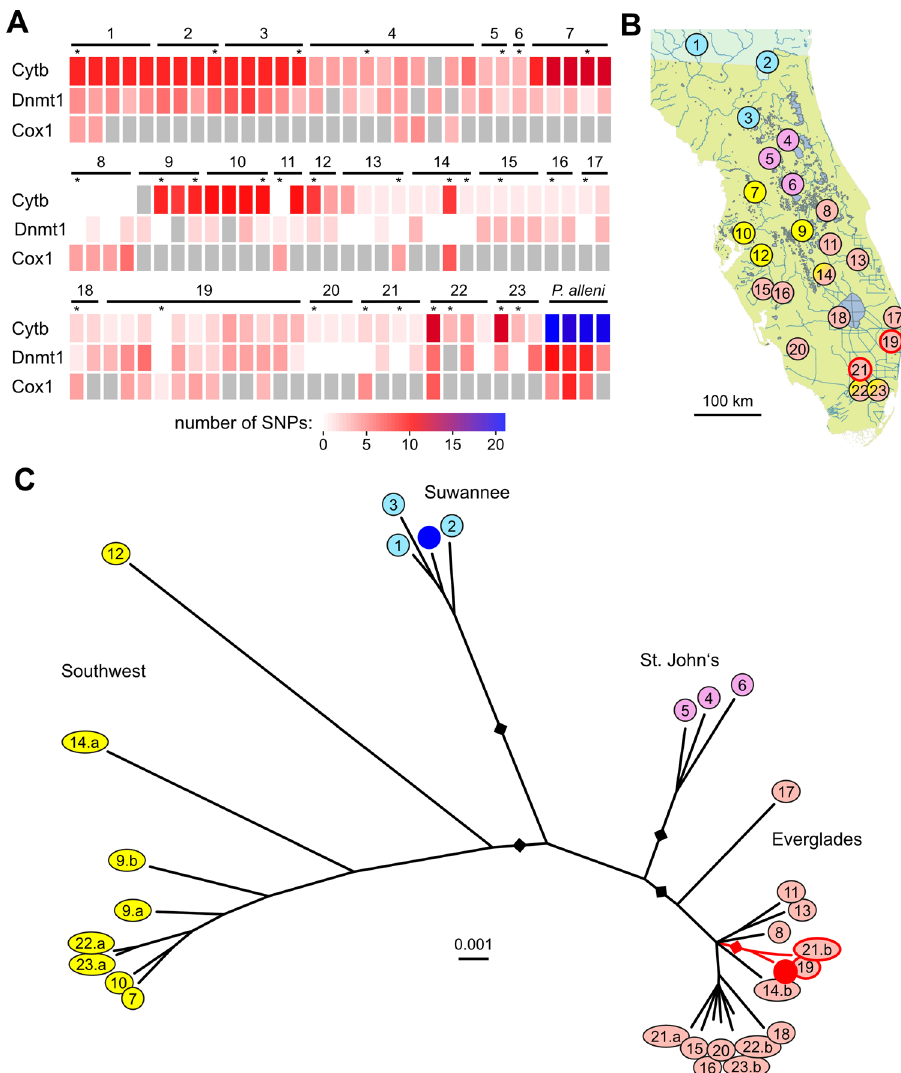
Fig. 1 Phylo-geographic analysis of wild-caught Procambarus fallax . A PCR genotyping results of 92 P. fallax sampled for this study. The heatmap indicates the number of genetic polymorphisms for speci fi c markers relative to the P. virginalis reference, on a scale from 0 (white) to 21 (blue). Grey boxes: not analyzed, asterisks denote animals that were also analyzed by whole-genome sequencing. The morphologically similar and sympatric cray fi sh species P. alleni ( N = 4) was included as a control and showed a clearly distinct genetic pro fi le. Sample numbers indicate individual sampling locations from 1 (northernmost) to 23 (southernmost); a and b indicates independent animals collected from the same location. B Map of Florida and southern Georgia, indicating the collection sites and the population structure. Three locations showed local sympatry of the Southwest and Everglades populations, as indicated by split coloring. C Phylogenetic tree, based on complete mitochondrial genome alignments. Colors indicate phylogeographically de fi ned populations that were named after the corresponding water catchment areas of Florida. The blue dot indicates the P. fallax mitochondrial genome reference sequence, the red dot indicates the monoclonal P. virginalis mitochondrial genome reference sequence. Animals that are particularly closely related to P. virginalis are highlighted by red lines. Rectangles represent bootstrap values for the branches that de fi ne subpopulations (black: 100%, red: